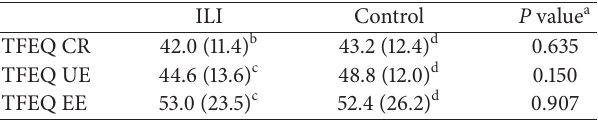
Table 7: Self-assessment of eating behavior (TFEQ-R21) at baseline in the intensive lifestyle intervention (ILI) group and control group. Data are given as mean values (standard